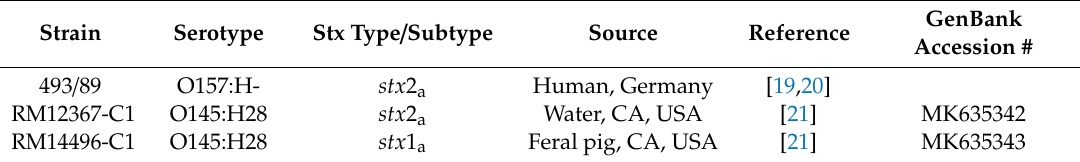
Table 1. Strains used in this